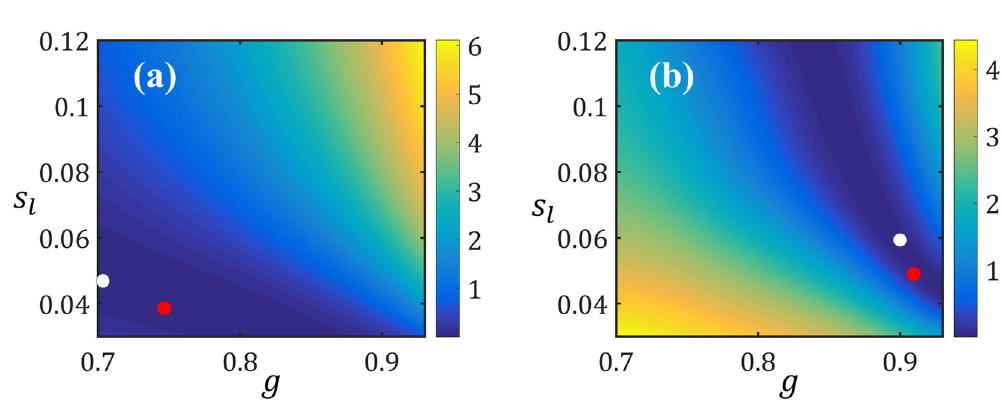
Figure 7. Contours of F as a function of the optimization variables: The fixed variables are estimated optima are indicated with, respectively, white and red dots in each